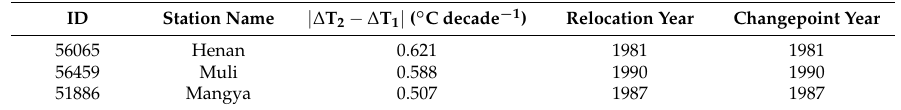
Figure 3. Comparisons between the raw and corrected data series at three stations. The absolute values of their difference in annual mean temperature trend are larger than 0.5 ◦ C decade − 1 : ( a ) Henan station; ( b ) Muli station; and, ( c ) Mangya station. Red and blue solid lines indicate the raw and corrected data series, respectively. Table 1. The relocation data and comparison between annual mean temperature variations before and after corrections in selected stations.